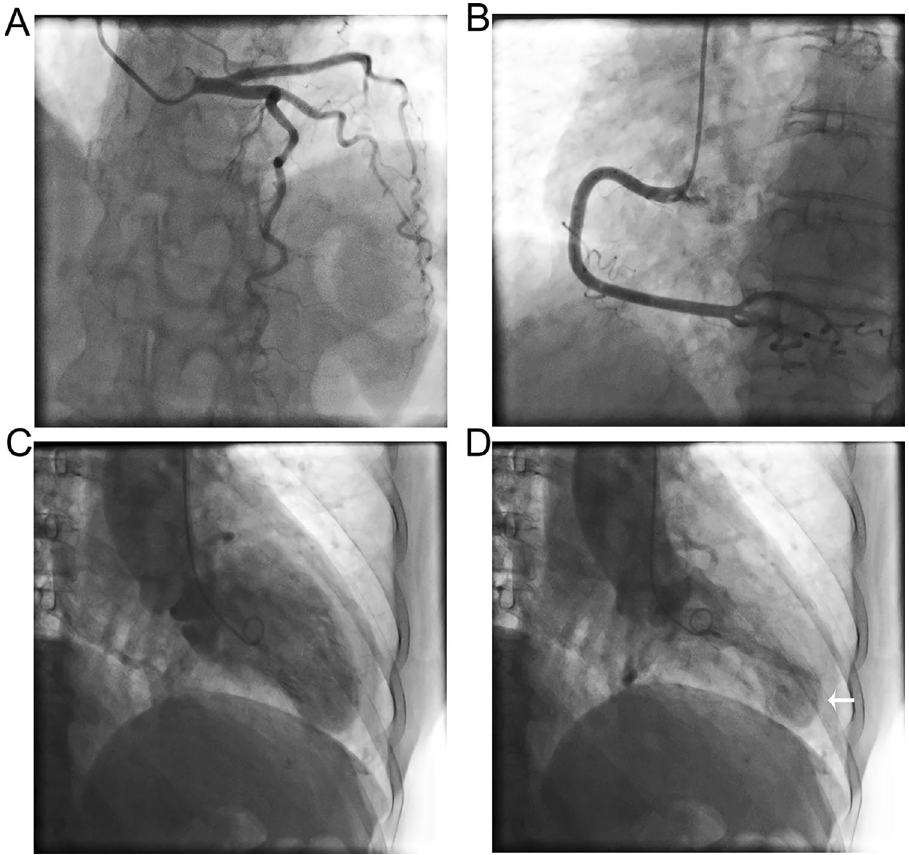
Figure 3. Coronary angiography and left ventriculography of a 81-year old woman showing apical TTS. ( A ) Left coronary artery; ( B ) right coronary artery; ( C ) diastolic period; ( D ) systolic period. Arrow points to